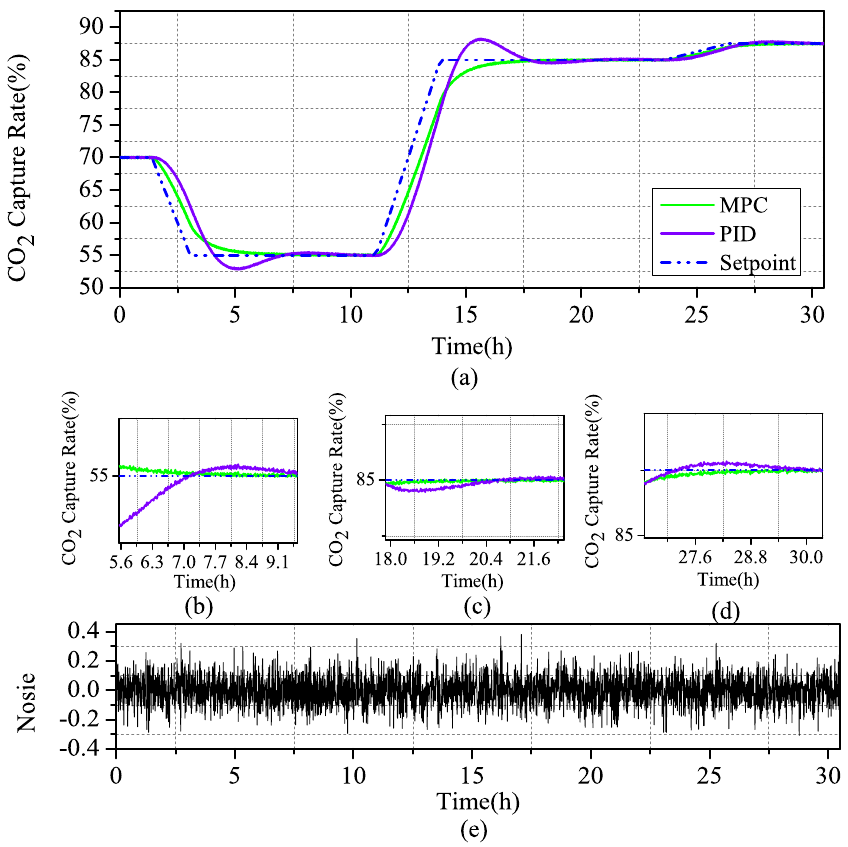
Figure 12. Scenario 2: ( a ) Comparison of MPC and PID simulation of controlled variables in CO 2 capture; ( b ) zoom in current ramp-down at 1.4 h; ( c ) zoom in current ramp-up at 11.1 h; ( d ) zoom in current ramp-up at 23.6 h; and ( e ) Gaussian distributed random signal in the